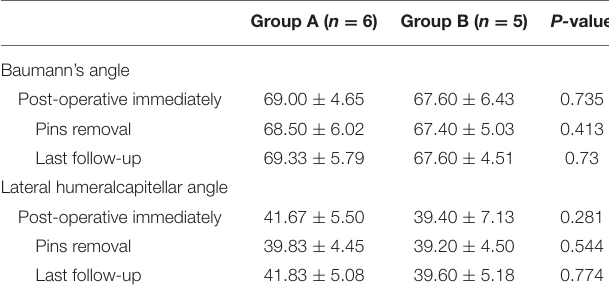
TABLE 1 | General descriptive data of the included Children. TABLE 2 | Radiographic Outcomes of successful CR in two groups in two